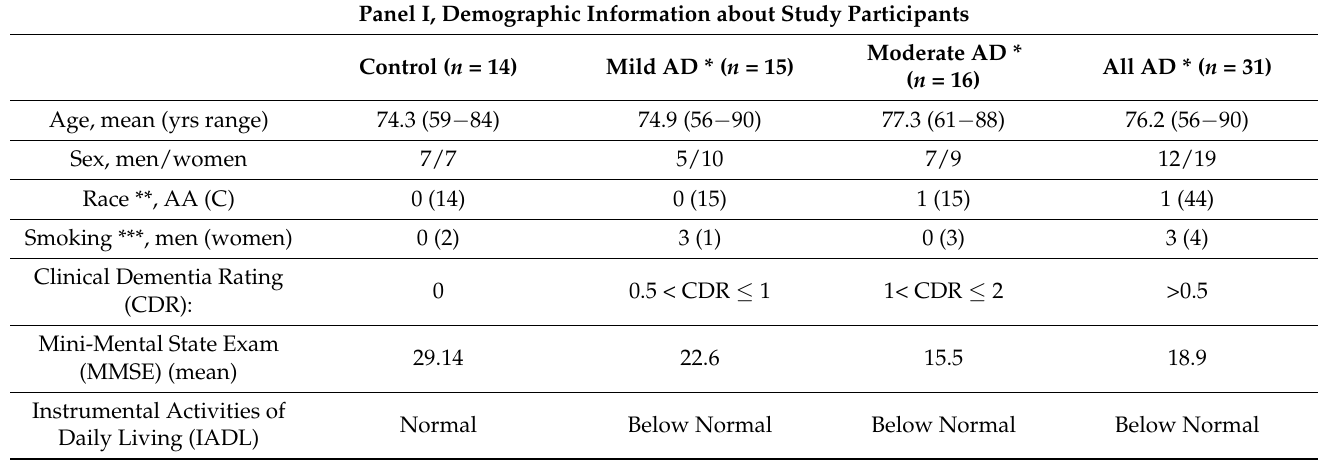
Table 1. Demographic and clinical information about study volunteers. Panel I, Demographic Information about Study